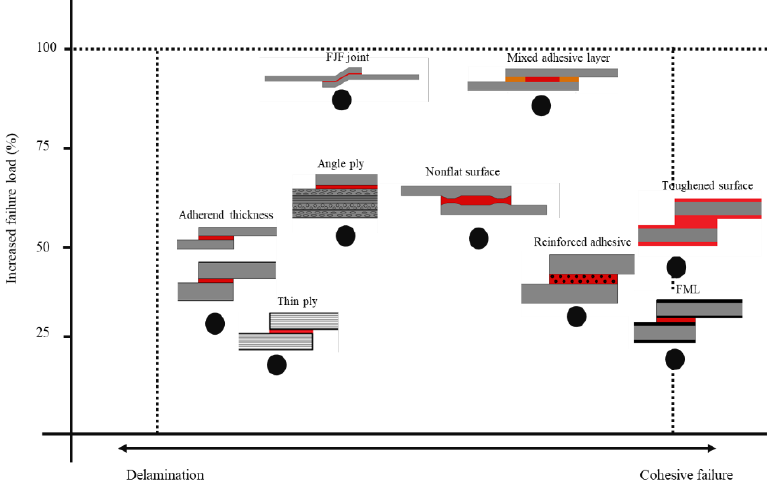
Figure 28. A comparison of different techniques in terms of strength improvement and failure mech- anism.